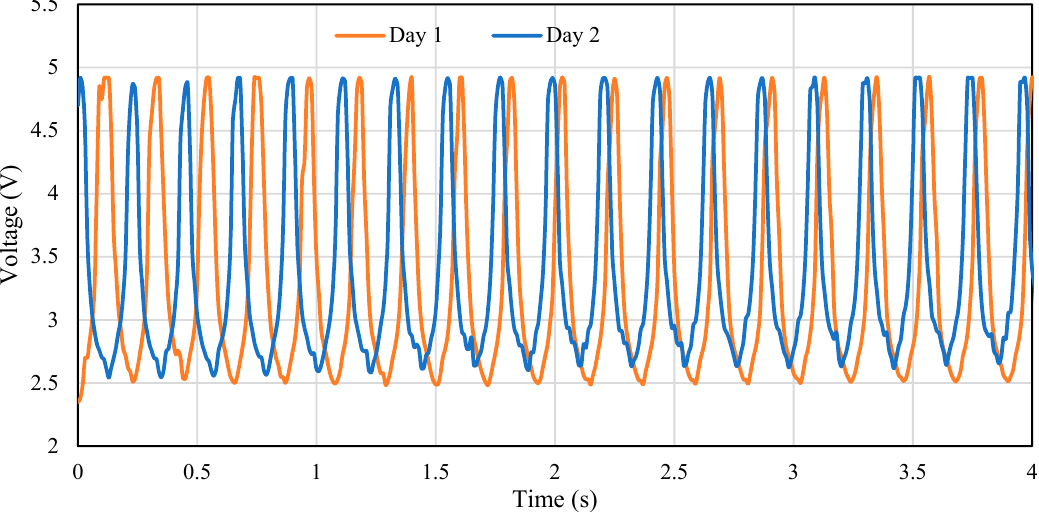
Figure 12. The output voltage of the sensor over time when placed on the simulator in two consecutive days under a volume strain of 17.3% and 154.2 BPM simulated by the respiratory simulator.